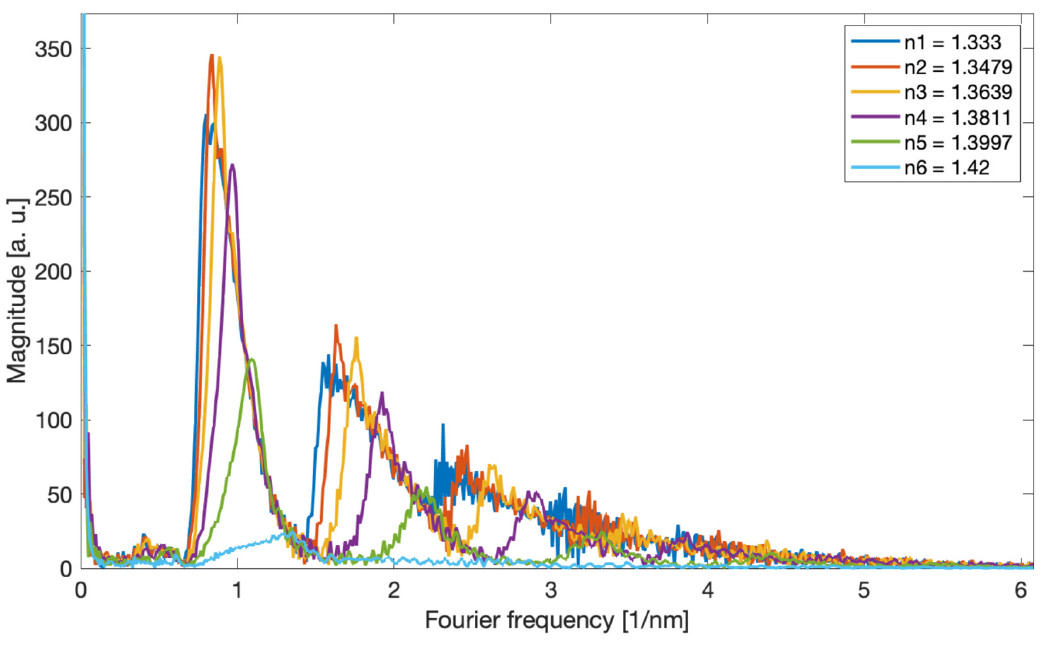
Figure 3. The amplitude Fourier spectrum corresponding to the optical spectra of the TFBG in Figure 2, depending on the SRI.